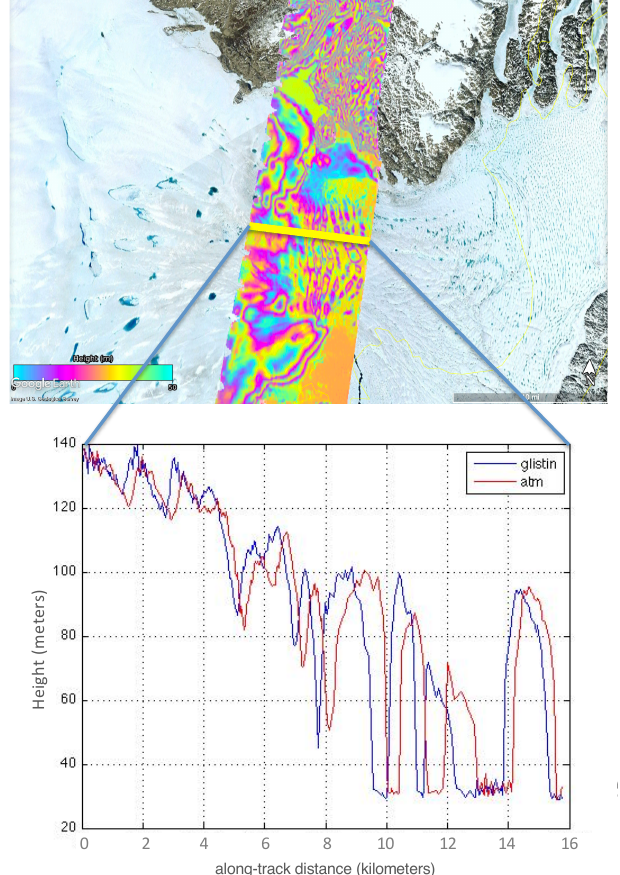
Figure 6. Zacharae glacier as observed by GLISTIN-A (31 March 2016) and by ATM (9 May 2016): ( Upper ) GLISTIN-A swath (colored contours, 50 m wrap) and a crossing ATM track (Yellow line) overlaid on Google Maps. ( Lower ) GLISTIN-A and ATM heights measured along the ATM track flying toward the ocean. The movement of the ice features can be clearly identified illustrating how this is an effective tool for velocity and volume change mapping but also that the dynamic glacial regions must be filtered from the validation